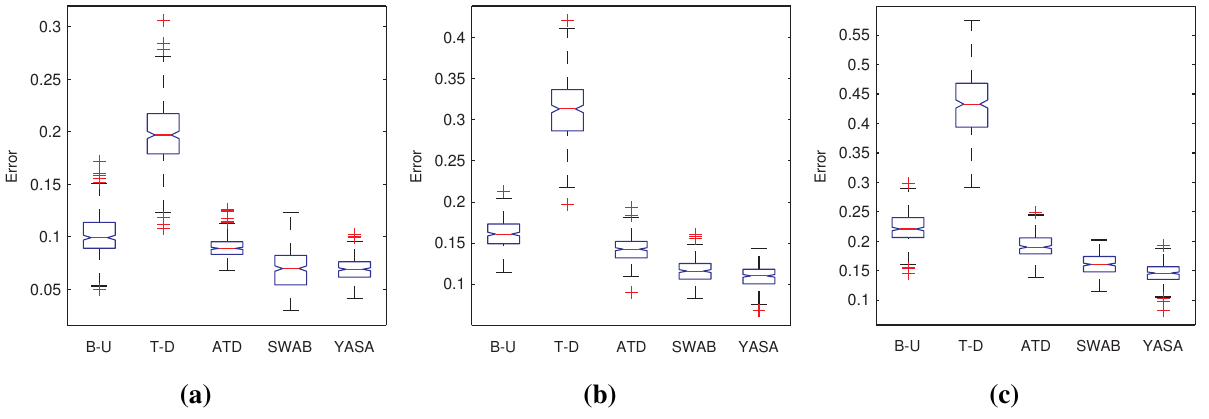
Figure 4. Box plots of the root mean squared errors yielded by the bottom-up (B-U), top-down (T-D), adaptive top-down (ATD), sliding window and bottom-up (SWAB) and our proposal (YASA). Data have been transformed for sensitivity reasons. ( a ) Errors for homogeneous series; ( b ) errors for multi-modal series; ( c ) errors for noisy series.